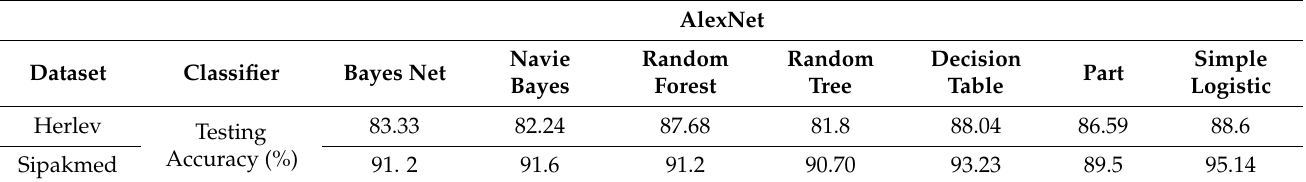
Table 6. Classification accuracy of Alexnet model with machine learning classifiers.